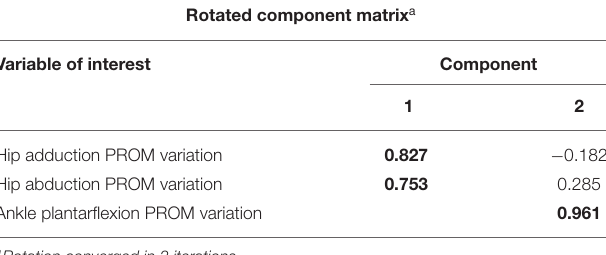
TABLE 4 | PCA Paretic PROM (76% explained